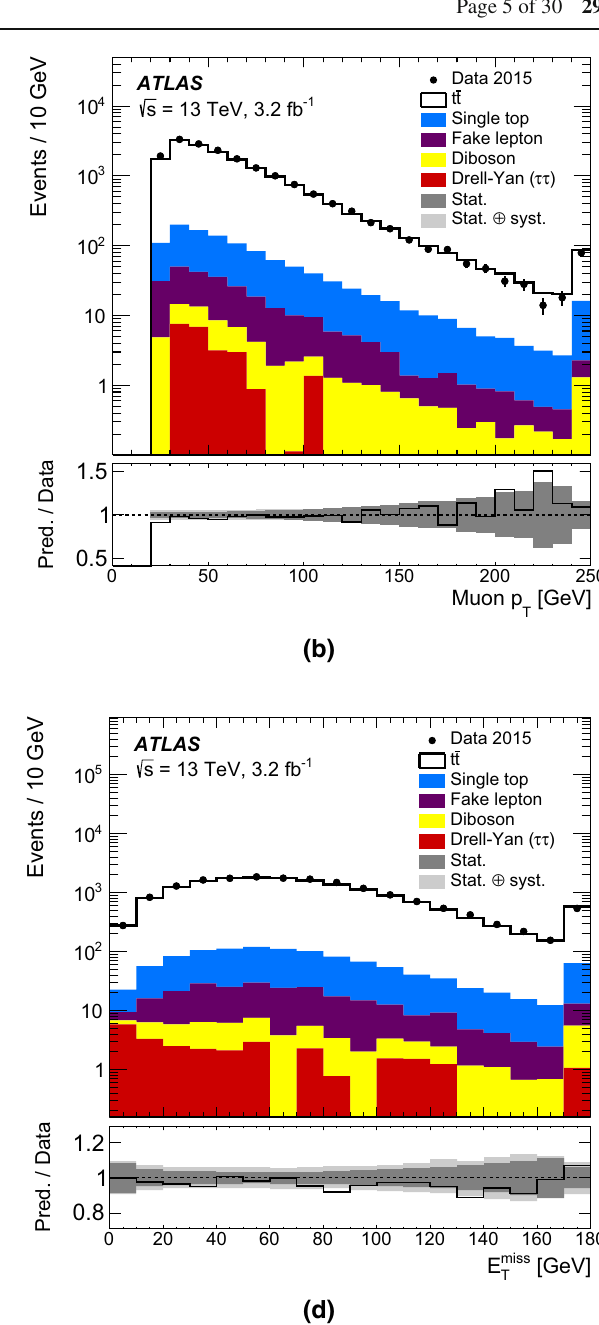
Particle-level objects are constructed using generator- level information in the MC simulation, using a procedure intended to correspond as closely as possible to the recon- structed object and event selection. Only objects in the MC